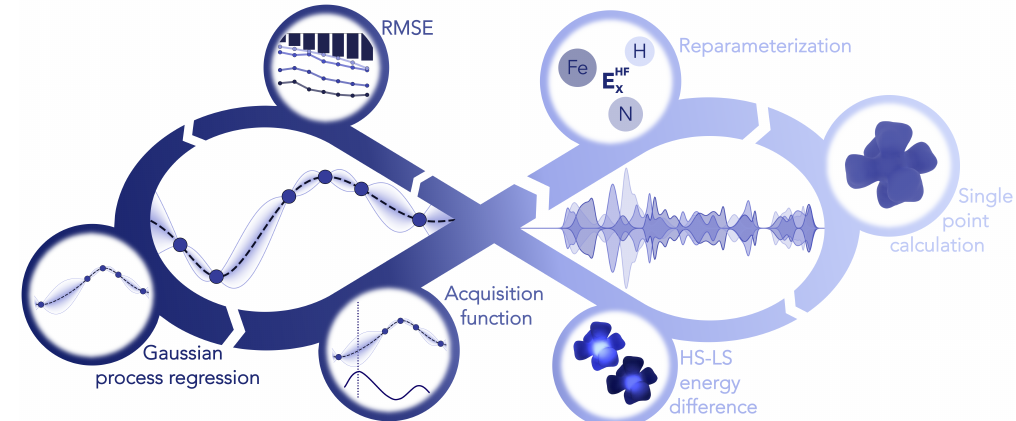
Figure 5. Diagram with an overview of the automated Bayesian optimization of PBE0r HF-exchange weights with the target function being the RMSE relative to the coupled cluster ∆ E HL values. The process starts with a sampling of different parameter values, computing the DFT ∆ E HL for the benchmark set. After computing the RMSE a Gaussian process regression is used to provide an acquisition function, selecting new values for the reparameterization and repeating the process.